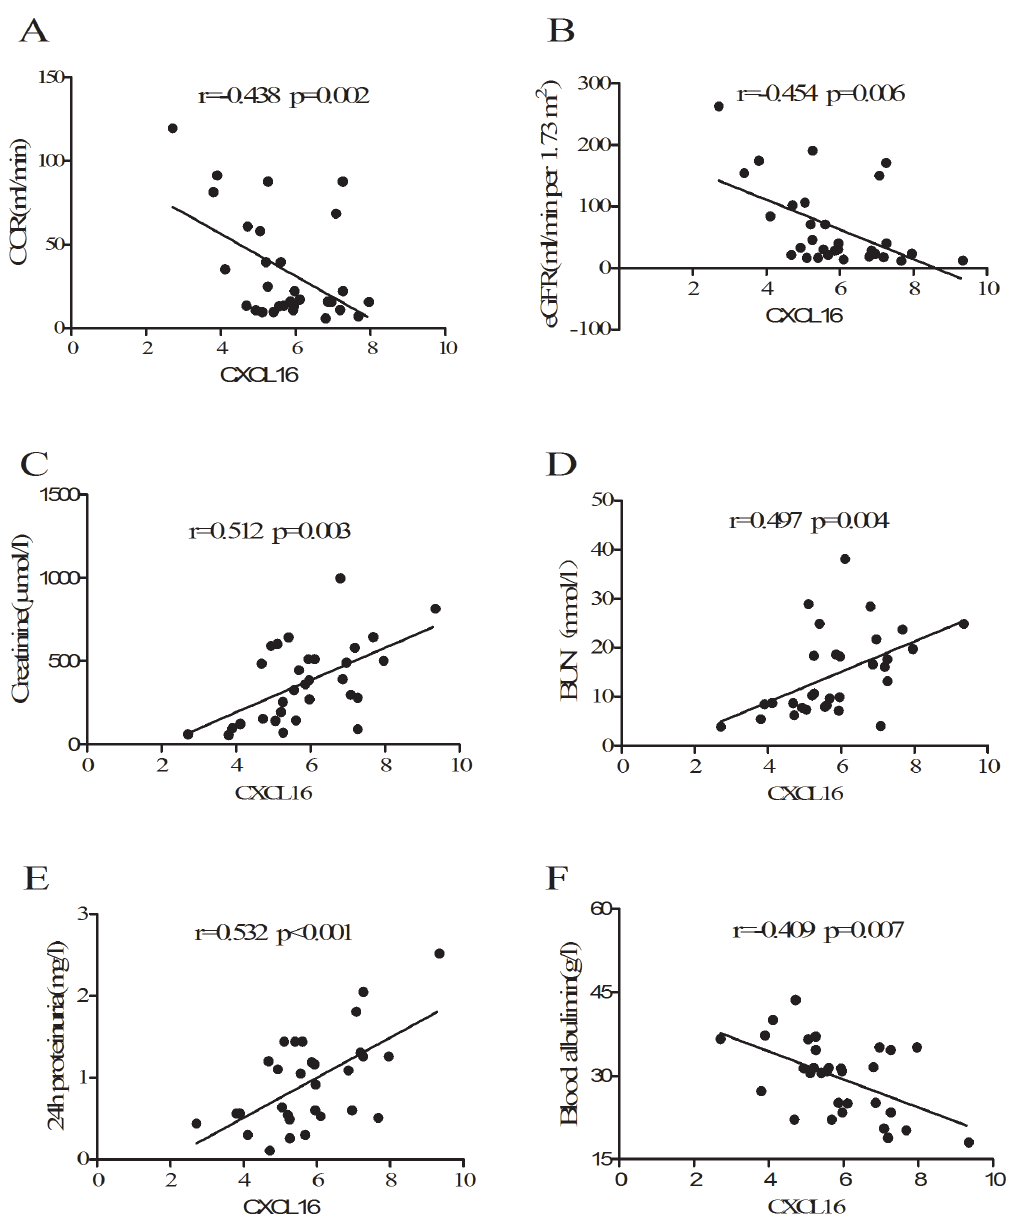
Figure 3. Correlation of serum CXCL16 levels with CCR (A), eGFR (B), creatinine (C), BUN (D), 24 h proteinuria (E), and blood albumin (F) in subjects with